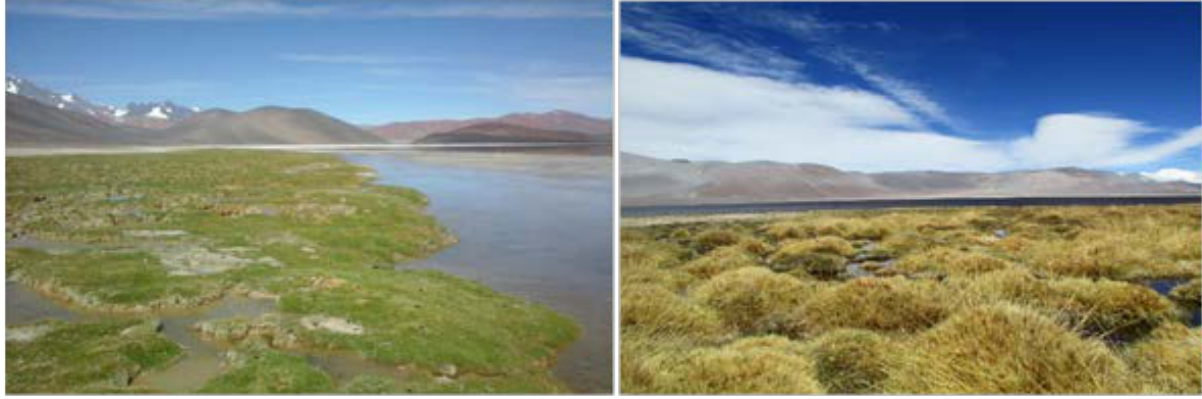
Figure 2. Representative images of the two different peatlands associated with Laguna Negra (left) and Laguna Tres Quebradas